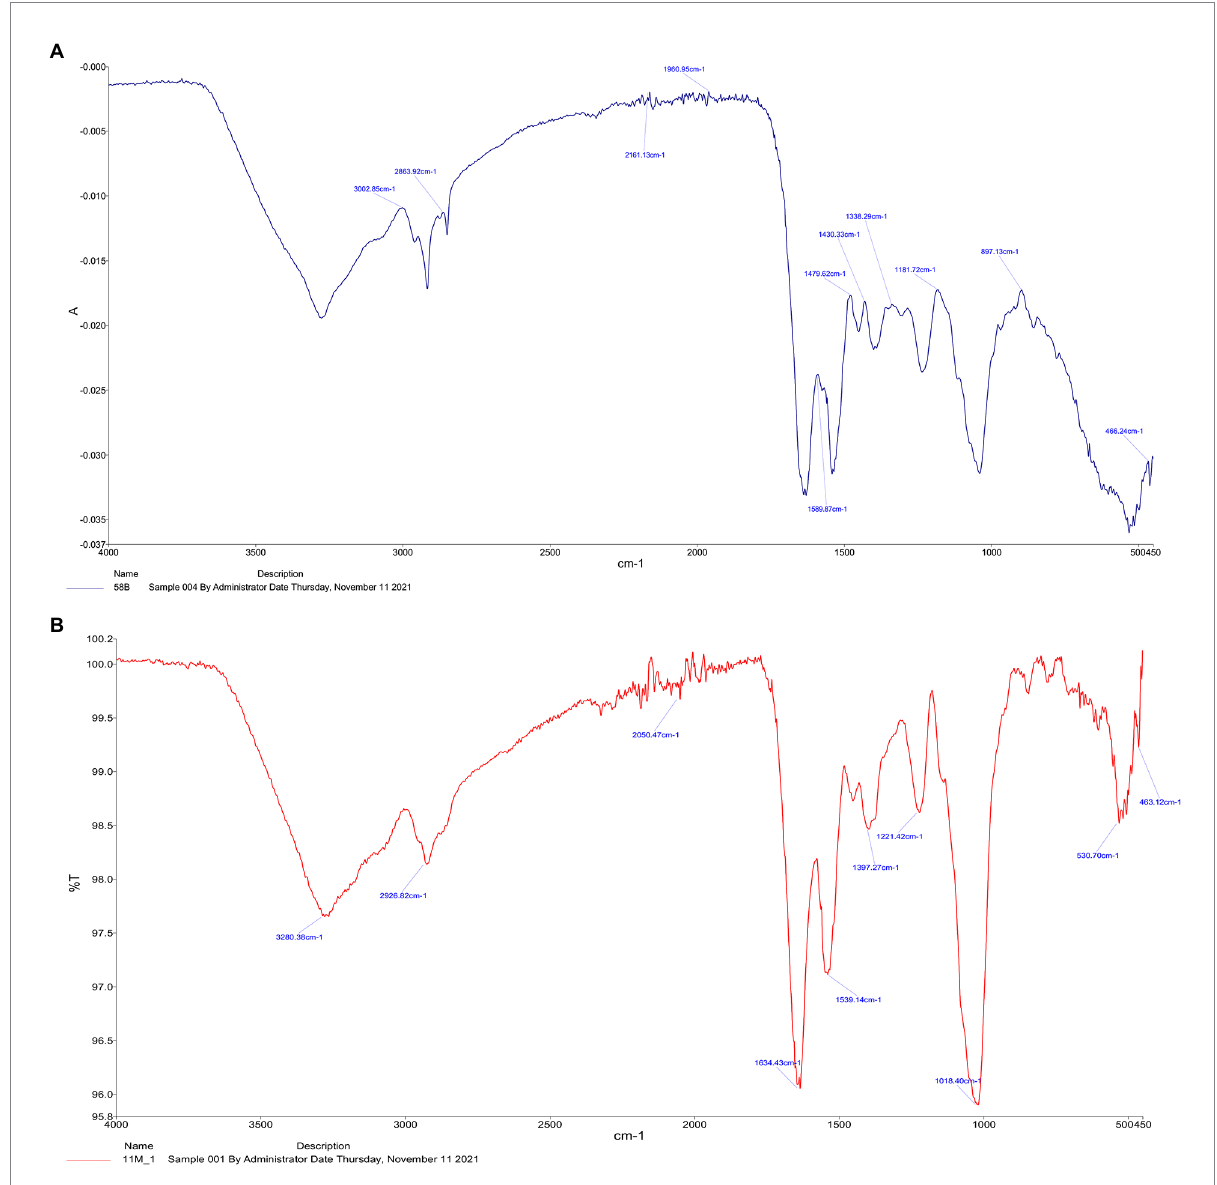
FIGURE 4 FTIR spectra of E. durans (A) and E. faecalis (B) .